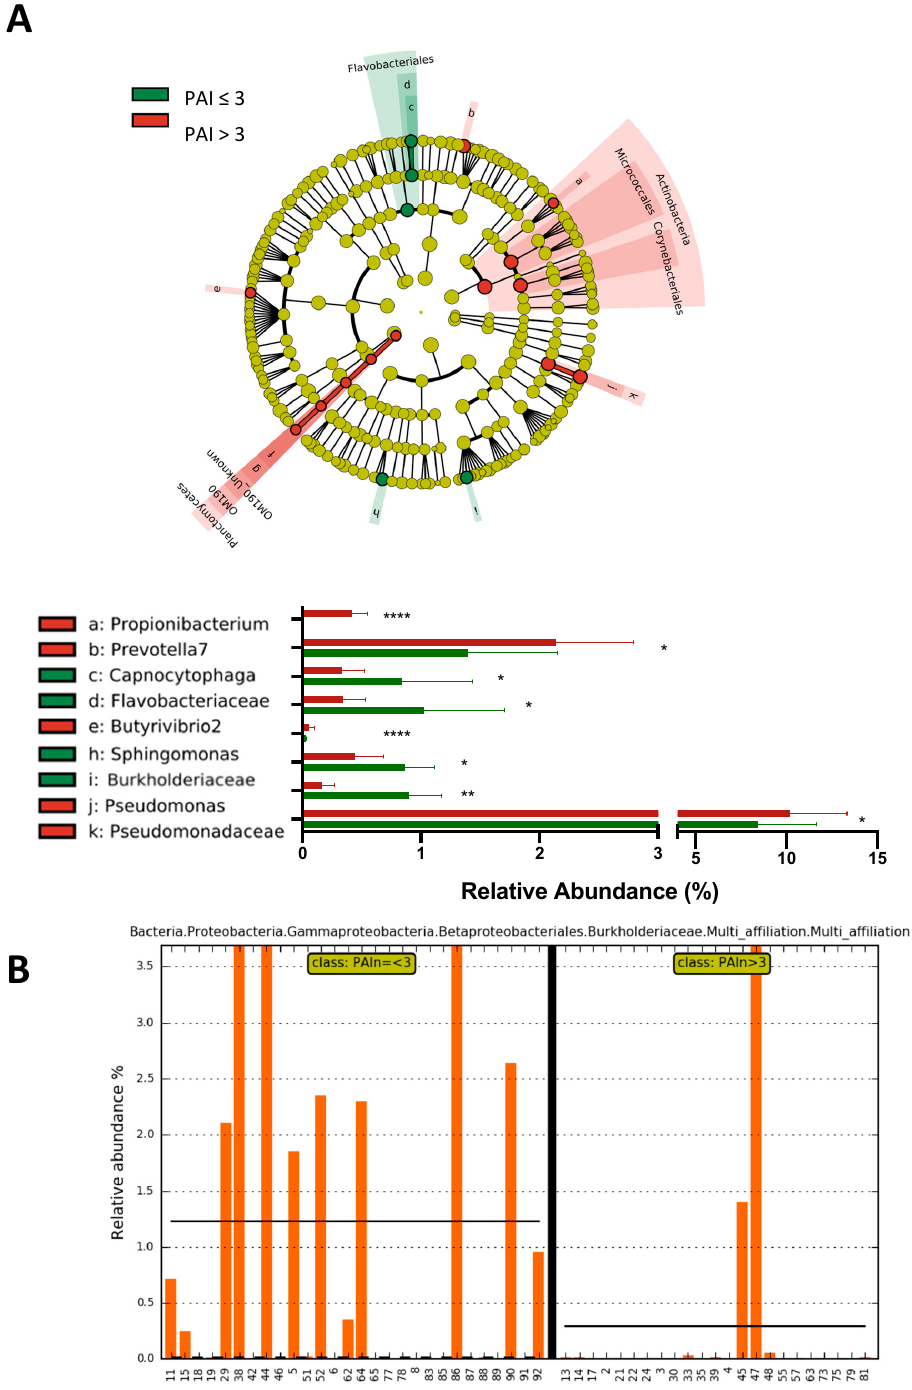
Figure 3. Microbiota profiles from granuloma in PAI ≤ 3 group (n = 44) show an increase in alpha diversity associated with the family Burkholderiaceae. ( A ) Linear discriminant analysis (LDA) effect size (LEfSe) cladogram of pairwise analysis for 16S rDNA sequence analysis of granuloma samples (the cladogram shows the taxonomic levels represented by rings with phyla at the innermost ring and genera at the outermost ring, and each circle is a member within that level) between two groups’– PAI ≤ 3 and PAI > 3—histogram for relative abundance (%) for taxonomic groups identified by single letters in cladogram. (Data as mean ± SEM; * p < 0.05, ** p < 0.01,**** p < 0.0001, unpaired Mann– Whitney test and LDA score 2.0 for cladograms). ( B ) Relative abundance of the Burkholderiaceae family per sample in PAI ≤ 3 and PAI > 3